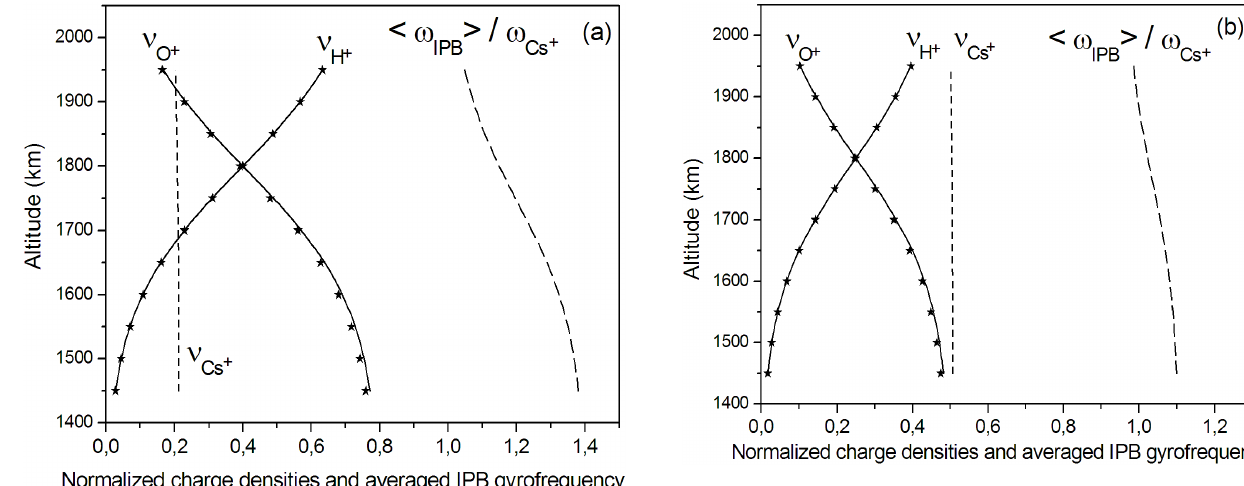
Fig. 1a. Altitude profiles of the relative charge densities of the three ion species H + , O + and Cs + , as well as of the normalized aver- aged gyrofrequency h ω IPB i /ω Cs + . The IPB is formed by Cs + ions which contaminate the ionospheric background plasma constituted by the two light ions H + and O + distributed in altitude according to a diffusive equilibrium type model. The solid lines show the corresponding values of ν O + and ν H + , taking into account that the assumed contamination by the Cs + ions does not depend on the alti- tude, whereas the superposed stars correspond to calculations based on Eq. (13). The dotted (resp. dashed) lines represent the recov- ered relative charge density ν Cs + and normalized averaged gyrofre- quency of the IPB, h ω IPB i /ω Cs + , respectively; (a) and (b) corre- spond to different levels of plasma contamination: (a) ν Cs + = 0 . 2; (b) ν Cs + = 0 . 5 .